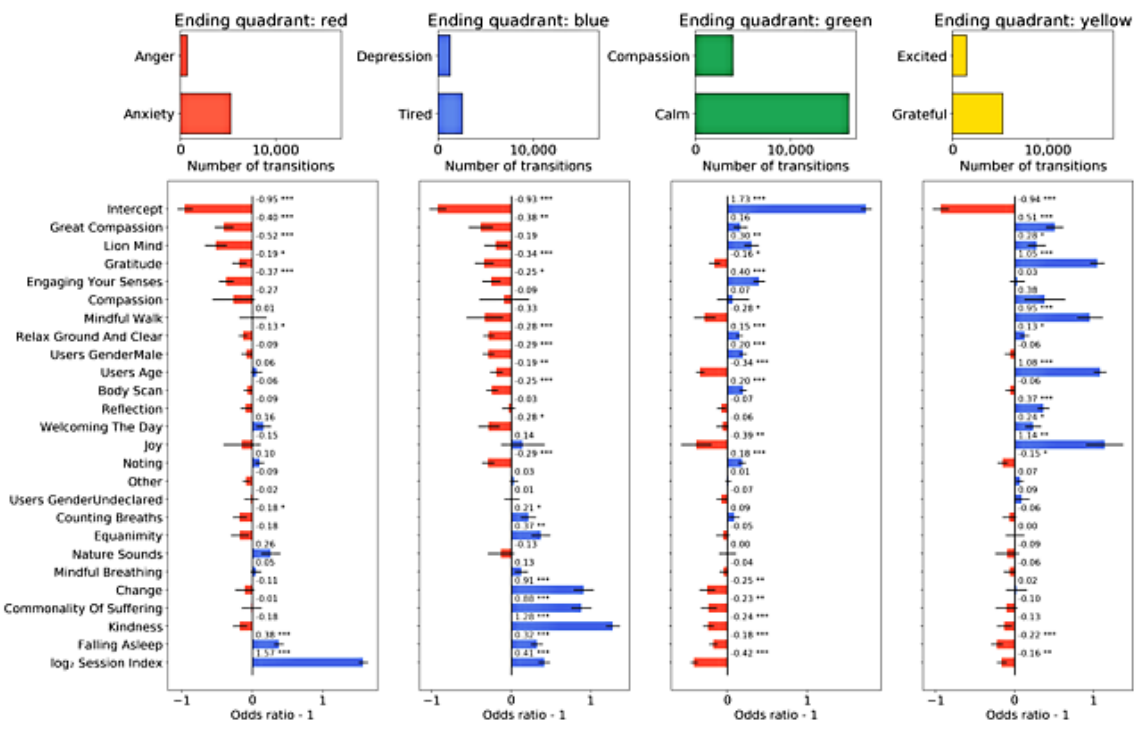
Figure 5. Transitions starting in Red Yale Mood Meter (YMM) quadrant model odds ratios. Sixteen GLM model fixed effect estimated odd ratios and P values (<.001***, <.01**, and <.05*) for mindfulness and meditation activities, gender, session index, and y-intercept split by starting YMM quadrant. Blue bars indicate increased propensity to make a transition, whereas red bars indicate decreased probability of making the transition. Transitions starting in Red YMM quadrant, where users who completed the MMA Lion Mind were 52% less likely to stay in Red, 30% more likely to enter Green, and 28% more likely to enter Yellow than those who did not complete Lion Mind.